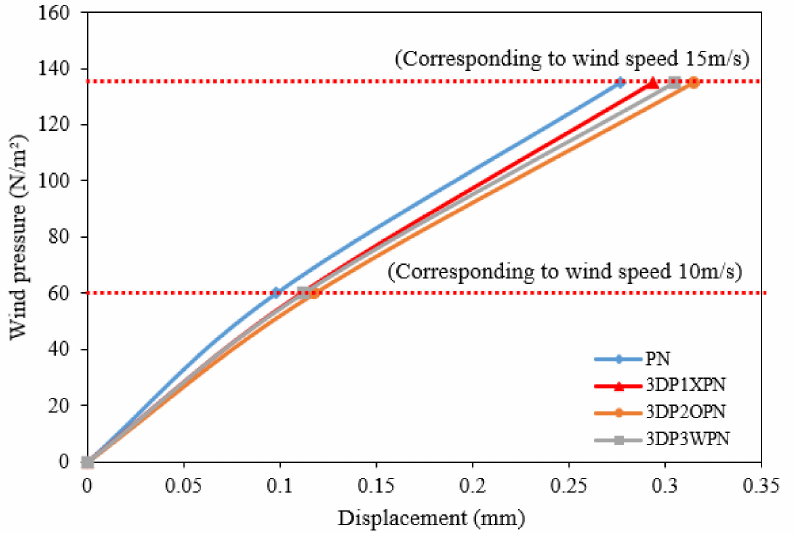
Figure 16. Wind pressure–displacement diagram of the lateral load